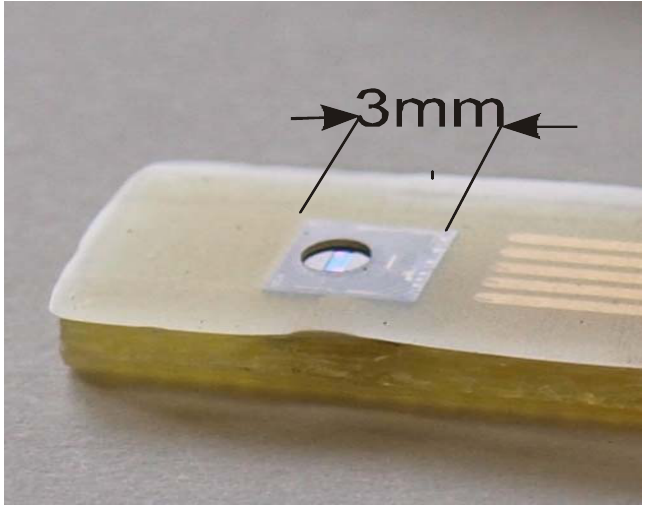
Figure 3. Photograph of a wire bonded and encapsulated ISFET chip.